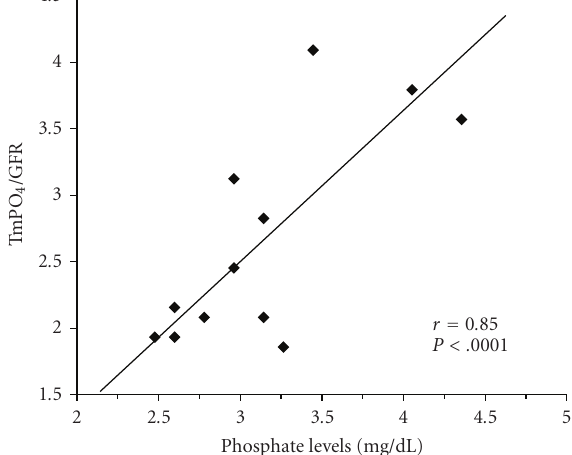
Figure 2: Correlation between TmPO 4 /GFR and P levels at 3 months postrenal